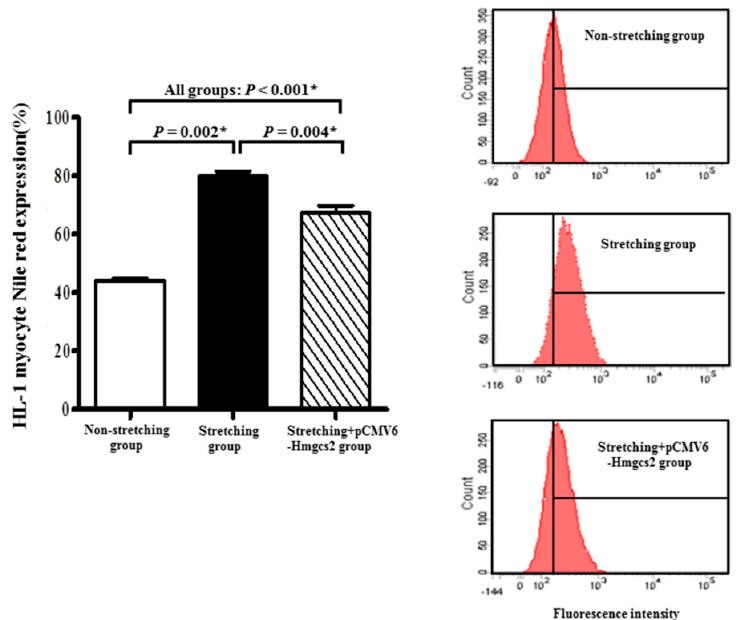
Figure 8. Left panel: Comparison of fraction of HL-1 atrial myocytes expressing Nile red in non-stretched HL-1 atrial myocytes, stretched HL-1 atrial myocytes, and stretched HL-1 atrial myocytes with genetic modification (plasmid transfection, pCMV6- Hmgcs2 ) of Hmgcs2 mRNA. Right panel: Fluorescence intensity measurements for Nile red expression in non-stretched HL-1 atrial myocytes, stretched HL-1 atrial myocytes, and stretched HL-1 atrial myocytes with genetic modification of Hmgcs2 mRNA. * p < 0.05.